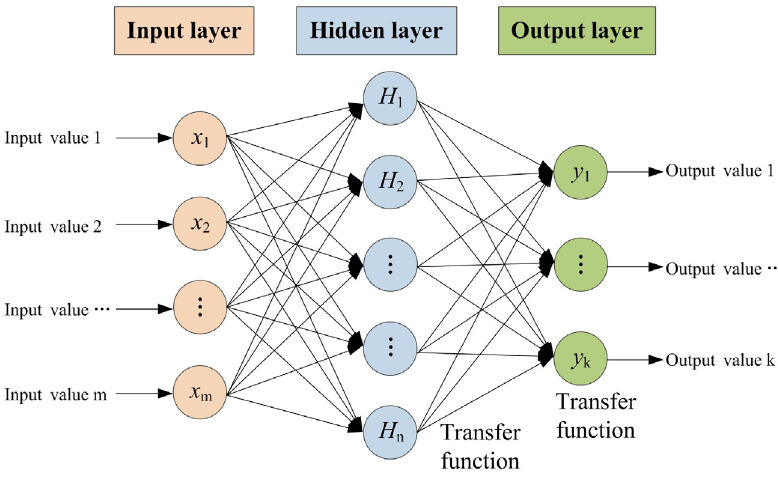
Figure 2. Sketch map of a typical three-layer